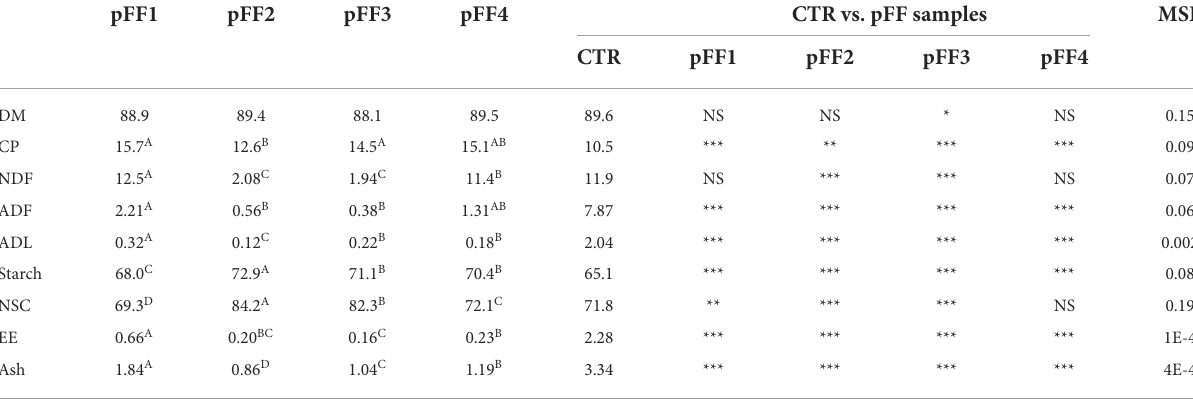
TABLE 2 Chemical composition of the different pasta former food and whole barley seeds (% DM) ( n = 4).